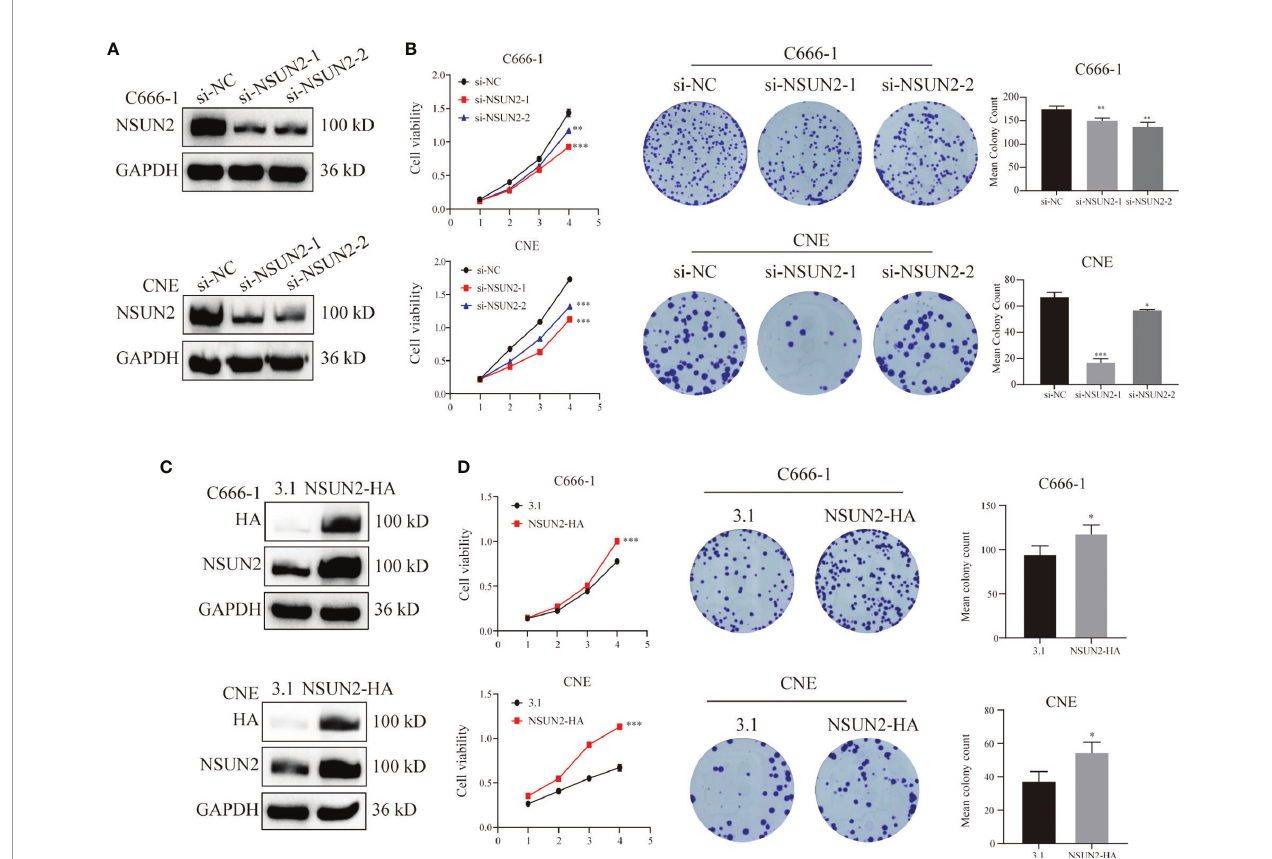
FIGURE 3 | NSUN2 promote the proliferation of NPC cells. (A, C) Western blot analysis showed the ef fi ciency of NSUN2 knockdown and overexpression in C666-1 and CNE cells. GAPDH as an internal reference. (B, D) The effects of knockout and overexpression of NSUN2 on the proliferation of NPC cells were evaluated by CCK8 and clone formation assay. * P < 0.05, ** P < 0.01, and *** P <